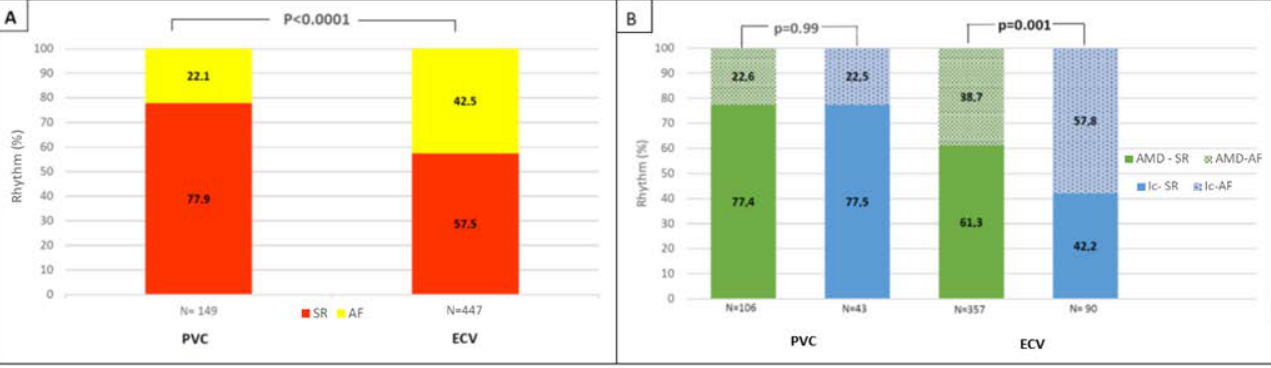
Table 2. Parameters associated with sinus rhythm maintenance at 3 months in univariate and multivariate analysis.